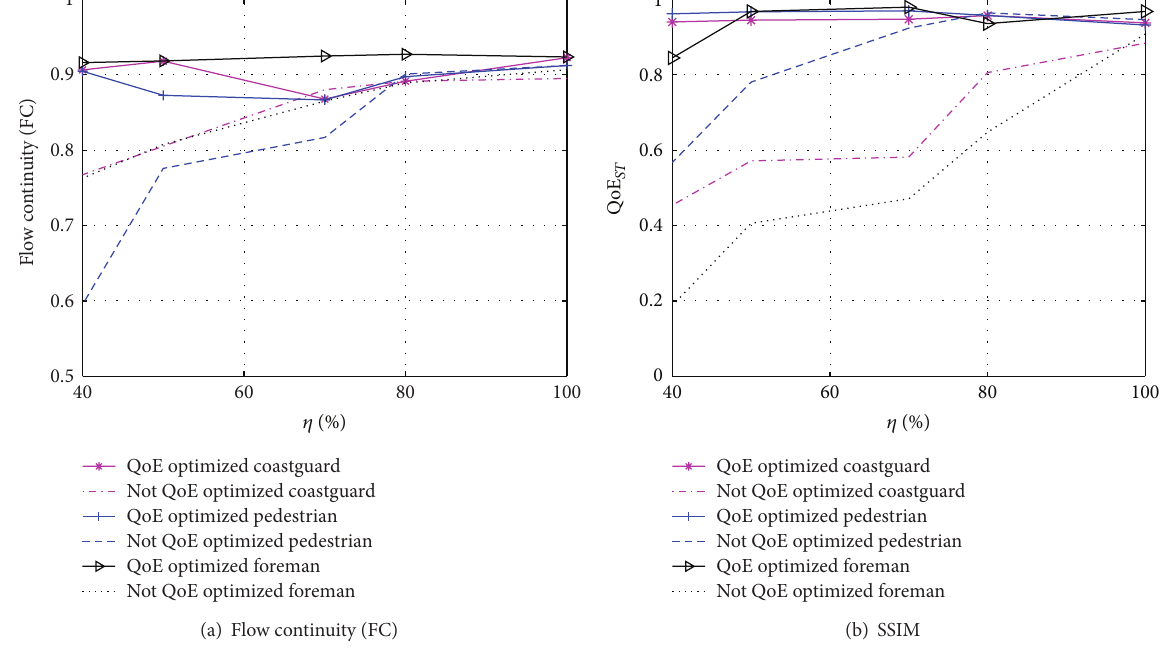
Figure 7: Evaluation of only QoE optimization in the time domain.